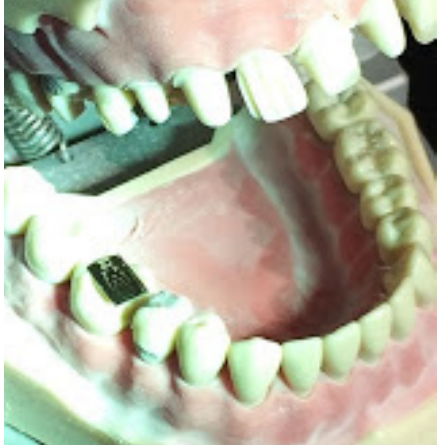
Figure 2. Miniaturized visual Snellen chart placed in the tooth cavity of a dental phantom.